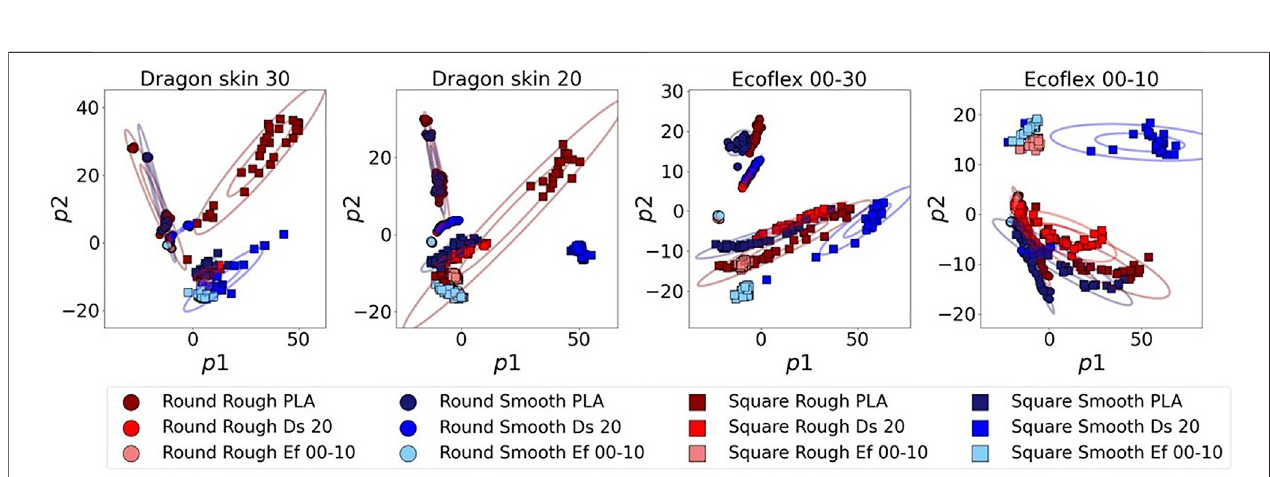
FIGURE 7 | PCA projections of the fi rst two principal components. The ellipses are drawn at one standard deviation and three standard deviations. “ Ef ” and “ Ds ” indicate Eco fl ex and Dragon Skin, respectively.